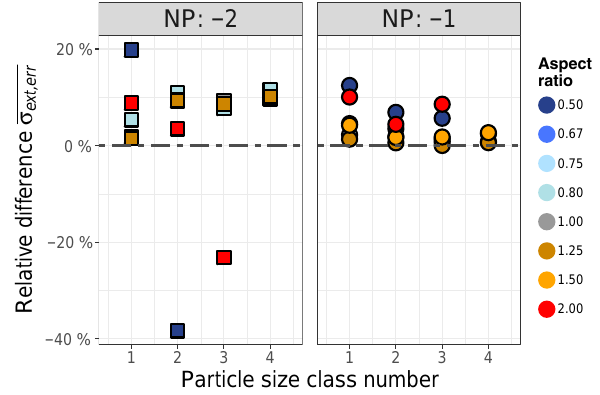
Figure 10. Relative errors of the effective extinction cross section if spherical particles are assumed but real particles have an elliptical (NP: − 1) or cylindrical shape (NP: − 2). Negative values indicate that spherical particles have a larger effective extinction cross sec- tion than equal-sized non-spherical particles and vice versa. The maximum relative differences are + 11 and − 35%.